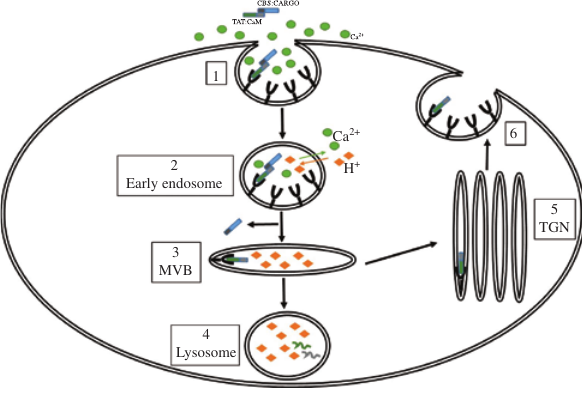
Figure 2: Proposed model for TAT:CaM-mediated intracellular deliv- ery of